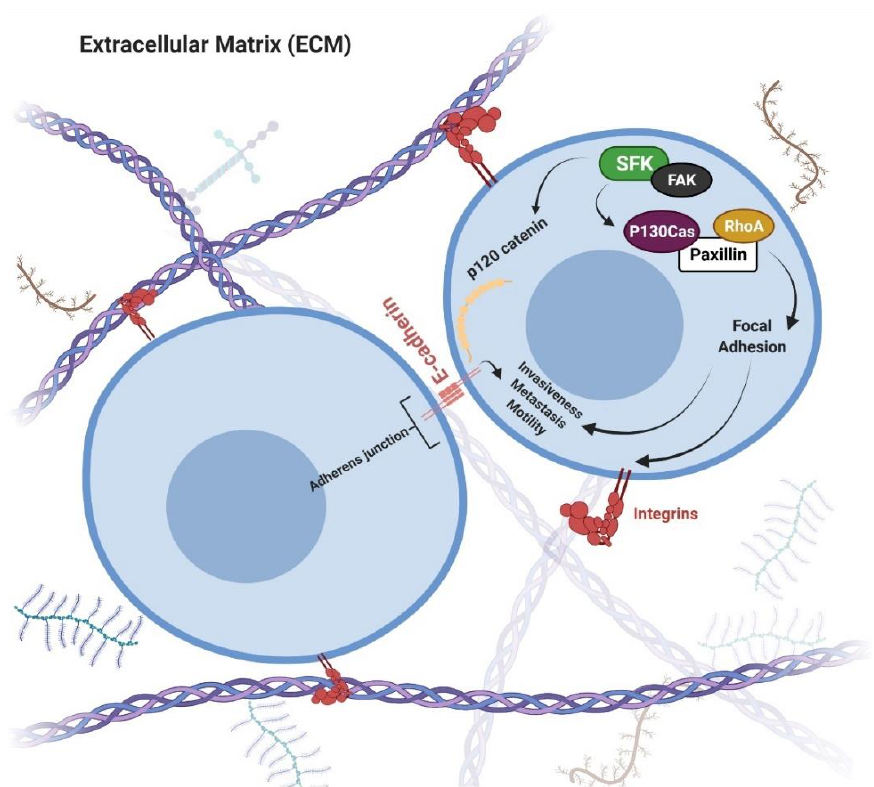
Figure 6. Activated SFKs can phosphorylate p120 catenin and FAK, causing destabilization of E-cadherin and adherens junction. The p130cas and paxillin are cell migration mediators. Src-FAK-p130cas axis causes cell invasion via MMP activation. All these cellular changes promote the invasiveness of cells.